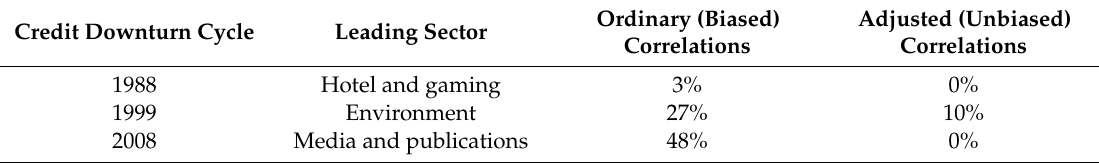
Table 2. Percentage of sectors exhibiting contagion compared with “leading” sector. Source: Author’s calculations. Note that the sectors with negative “stress” correlation coe ffi cients were excluded from the percentages presented. The contagion tests were calculated as specified in Table 1 using the sample periods specified in the main